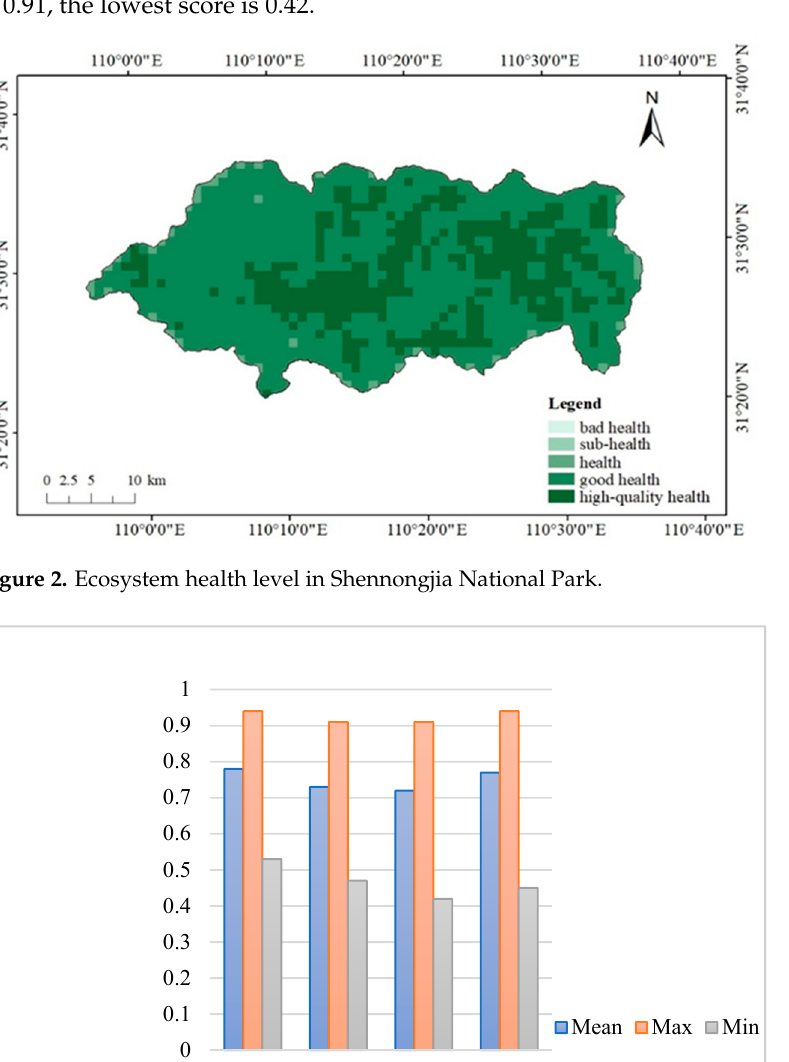
Figure 2. Ecosystem health level in Shennongjia National Park.